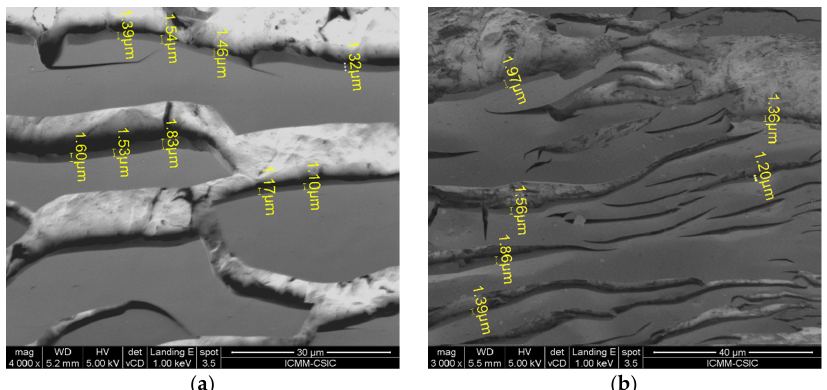
Figure 8. Cross-section micrograph obtained by SEM analysis for the hybrid coatings synthesized from the [TMOS]/[MPTS] mixture: ( a ) 25 °C for 45 days and ( b ) 65 °C for 4 h.